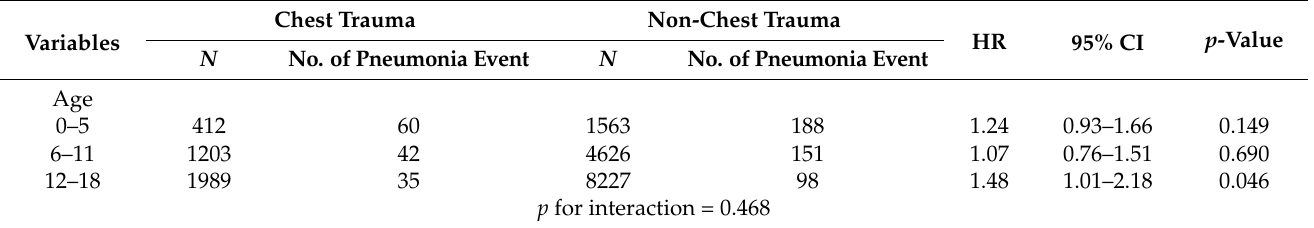
Table 3. Subgroup analysis of Cox proportional hazard model of pneumonia